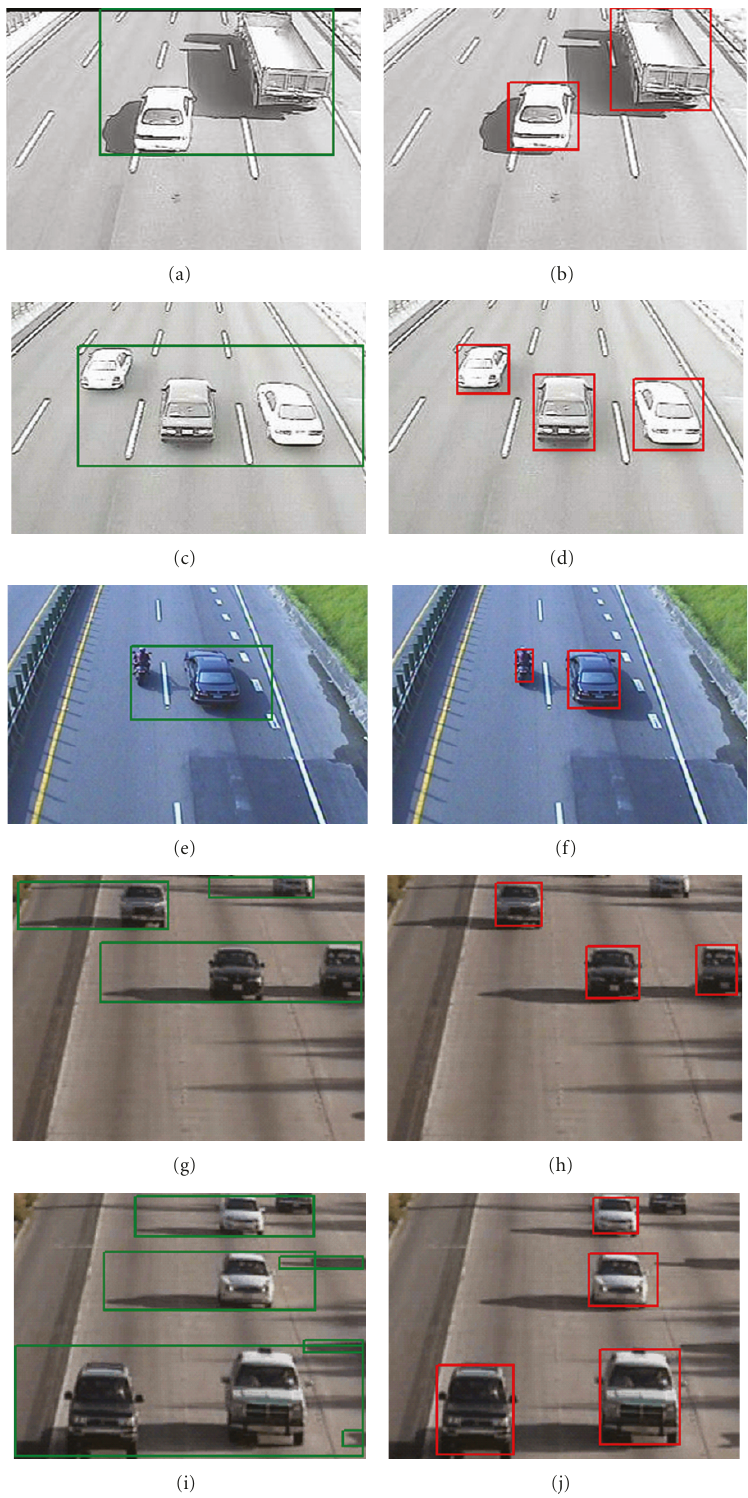
Figure 30: Experimental results under the occlusion